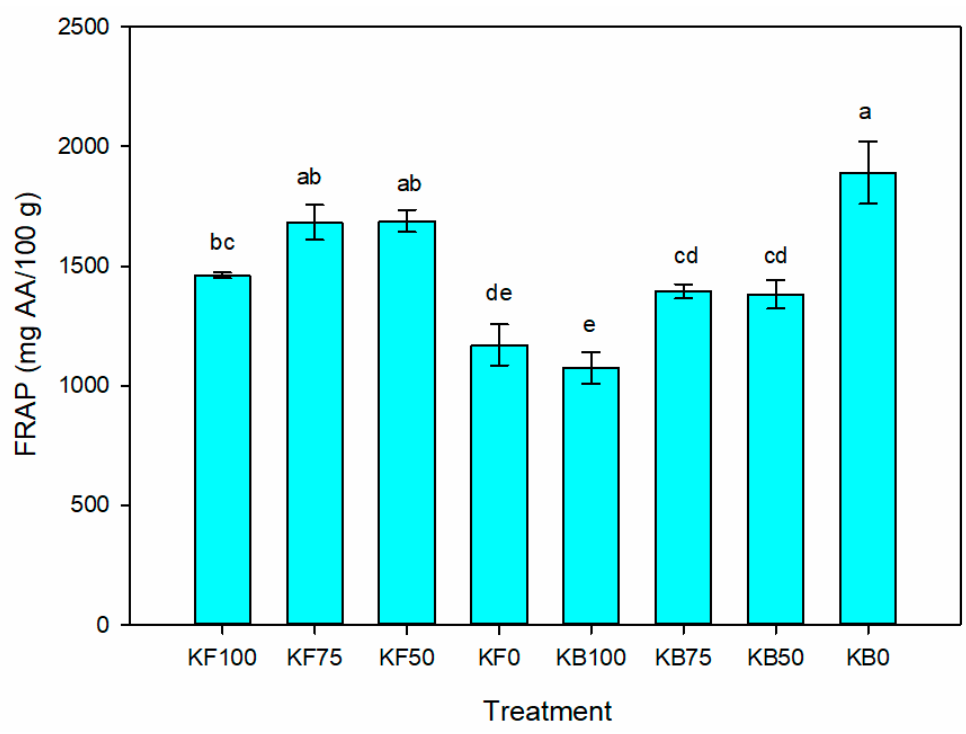
Figure 1. Antioxidant capacity (FRAP) of tomatillo fruits ( Physalis ixocarpa Brot. cv. “c á scara morada”) in the evaluation of the biofertilizing effect of Acinetobacter calcoaceticus UTMR2 at different doses of potassium. Concentration in dry-weight basis (mg ascorbic acid (AA)/100 g dw). KF#: treatments with chemical fertilization only; KB#: treatments with chemical fertilization and biofertilization; #: potassium fertilization dose (%) based on the recommended dose for tomatillo cultivation [20]. Different letters in the columns indicate a significant difference between the treatments according to the HSD Tukey test ( p < 0.05, n = 3).